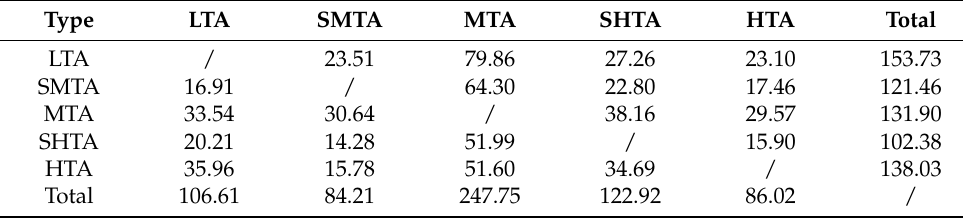
Table 2. Transition probability matrix of LST grades in Xi’an during 1999–2019 (km 2